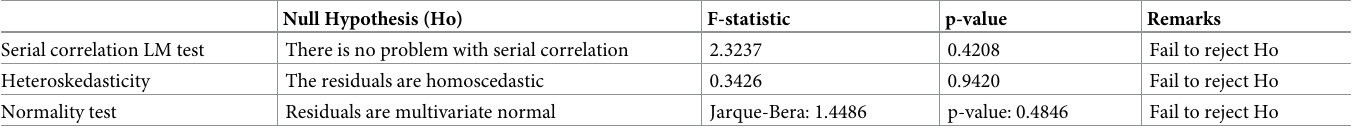
Table 9. Diagnostic